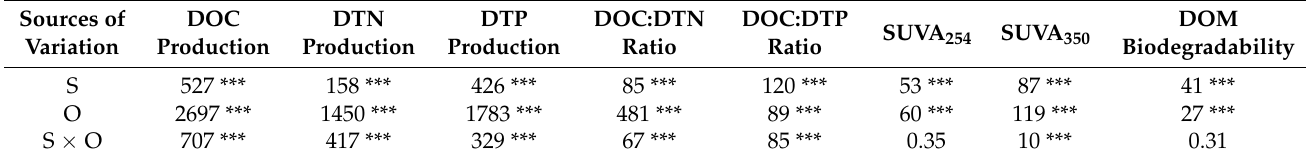
Table 2. Results ( F -values) of linear mixed models on the effects of tree species (S), organ type (O), and their interaction on tree tissue-leached DOM properties and biodegradability in subtropical plantations in southern China.